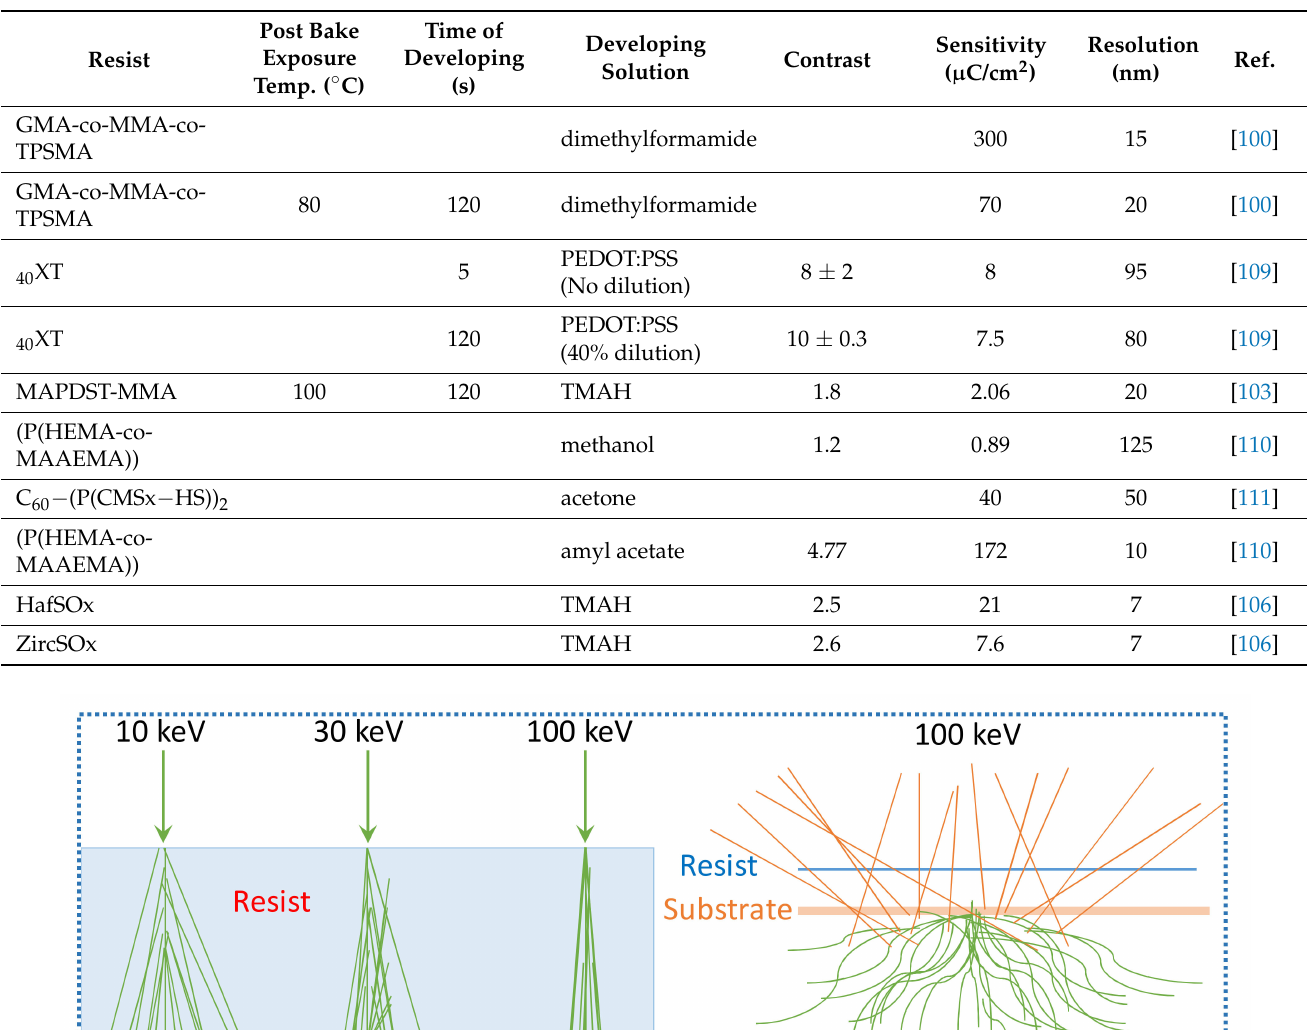
Table 3. Advanced resists for EBL technique.